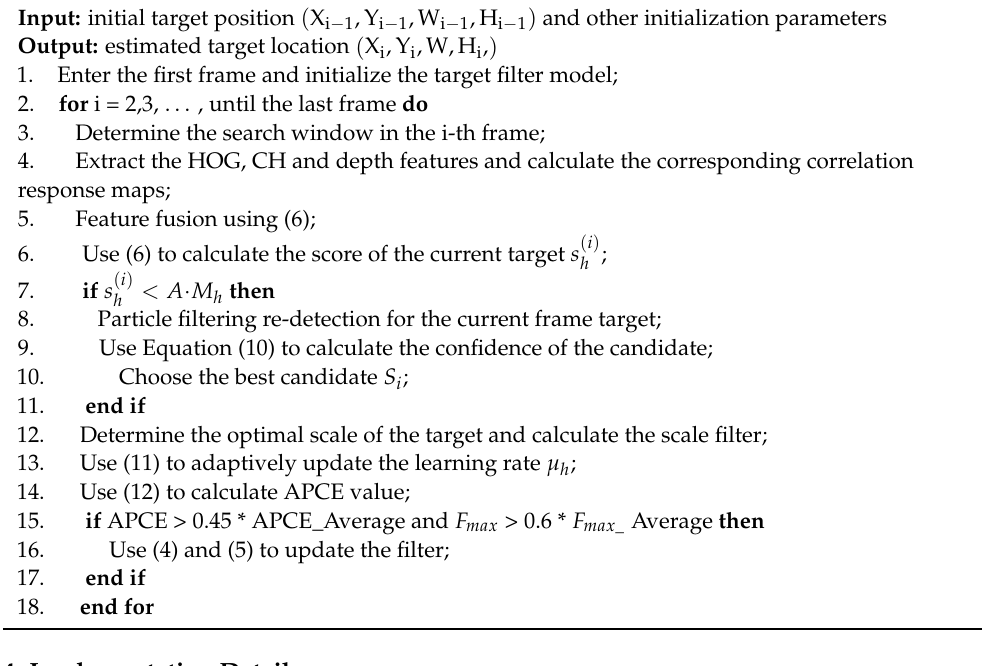
Algorithm 1: Multi-Feature Single-Target Robust Tracking Algorithm Fused with Particle